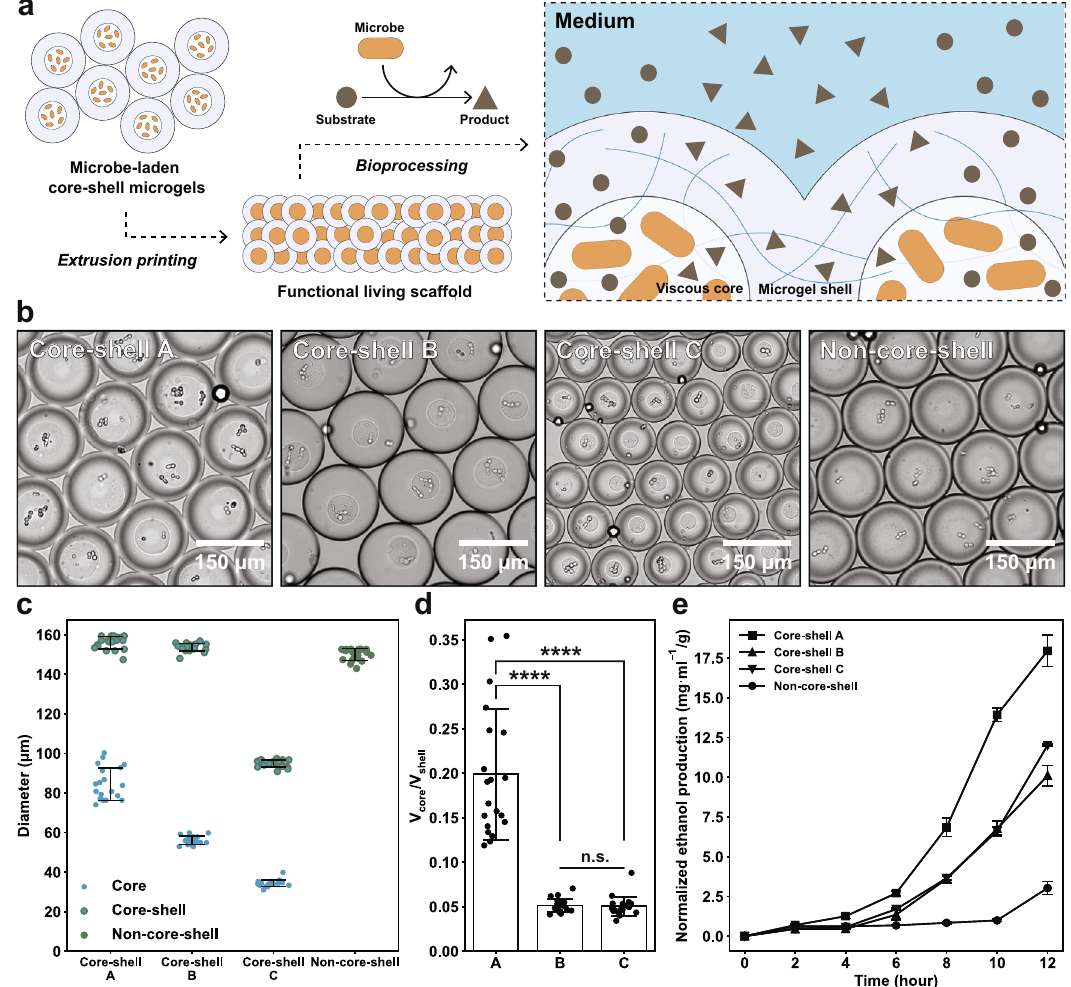
Fig. 4 | Bioprinting yeast-laden scaffold for ethanol fermentation. a Schematic of thefabricationoffunctionalliving scaffolds.Microbe-ladencore-shellmicrogels are generated via droplets micro fl uidics and printed into annealed scaffolds that are usedfor bioprocessing,where the microbes actasthe whole-cell biocatalyst to convert the substrate into productin the medium. b Micrographs of the core-shell microgels with varied sizesand non-core-shellmicrogels. c The sizedistributionof the core-shellmicrogelsand non-core-shell microgelsin b , n =20microgelsin one experiment. d Thevolumeratiobetweenthecoreandtheshellphaseforcore-shell